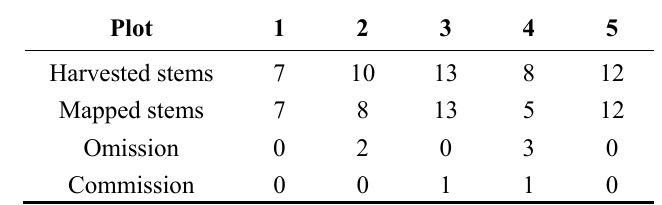
Table 4. Summary of change detection from the single-scan TLS data.